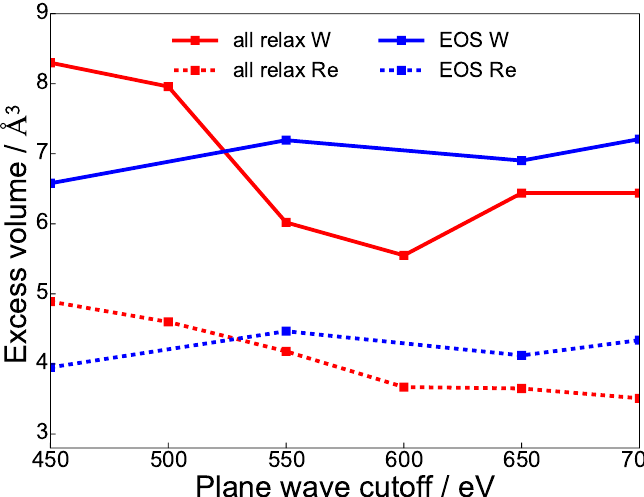
Figure 2. Calculated excess volumes for Re and W as a function of the plane wave cutoff for different methods determining the equilibrium